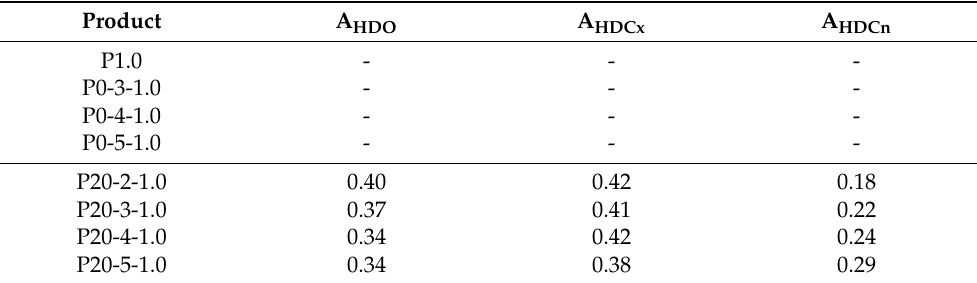
Table 4. The shares of the HDO, HDCx and HDCn reactions during the RO conversion in the